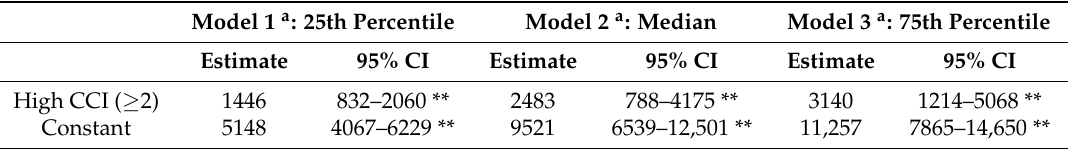
Table 2. Regression models of adjusted median and percentile costs associated with hospitalised cases of acute